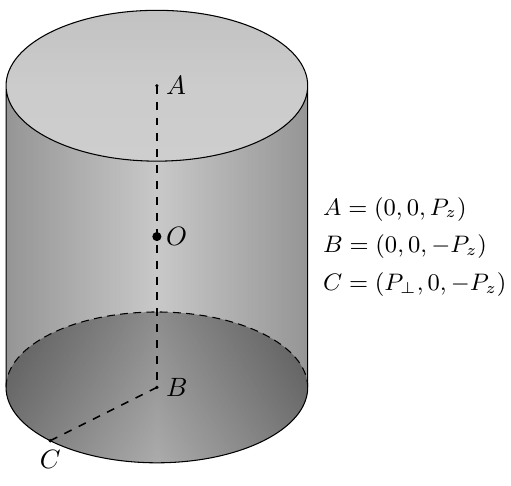
Figure 4 . Illustration of the chosen surface for the computation of (cid:13)ux of the Berry curvature in a multi-Weyl semimetal (see appendix A). The Weyl monopole is placed at O . Note that (cid:6) , (cid:6) and (cid:6) respectively represents the side ( S ), top ( T ) and bottom ( B ) S T B surfaces of the